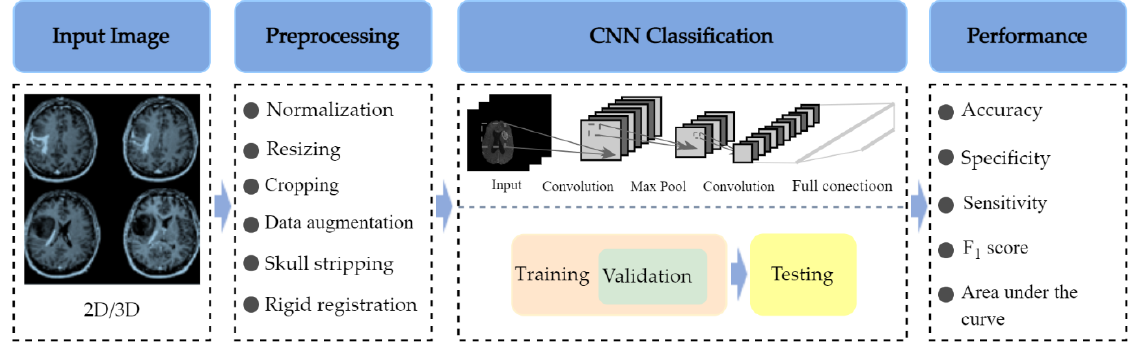
Figure 2. The basic workflow of a typical CNN-based brain tumor classification study with four high-level steps: Step 1. Input Image: 2D or 3D Brain MR samples are fed into the classification model; Step 2. Preprocessing: several preprocessing techniques are used to remove the skull, normalize the images, resize the images, and augment the number of training examples; Step 3. CNN Classification: the preprocessed dataset is propagated into the CNN model and is involved in training, validation, and testing processes; Step 4. Performance Evaluation: evaluation of the classifica- tion performance of a CNN algorithm with accuracy, specificity, F 1 score, area under the curve, and sensitivity metrics.